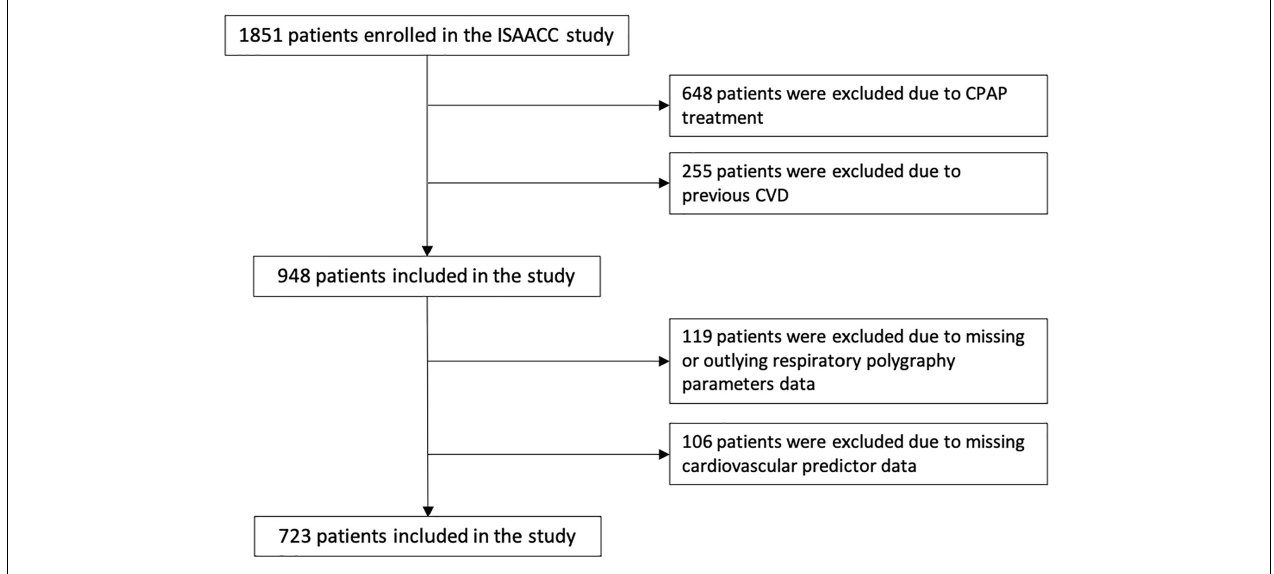
FIGURE 1 | Flowchart of study. CPAP, continuous positive airway pressure; CVD, cardiovascular disease.